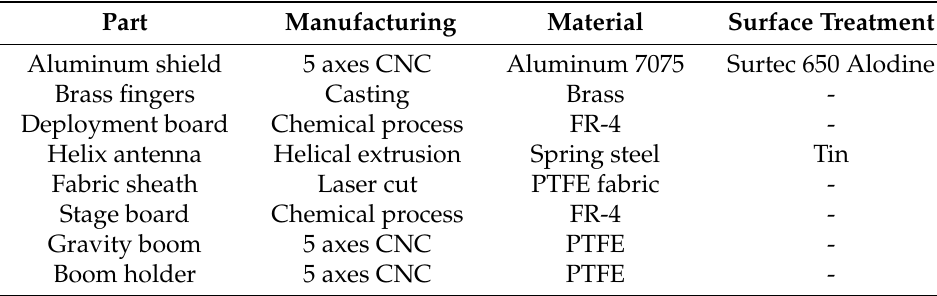
Figure 12. Extruded view of the NADS. Table 13. Materials of NADS